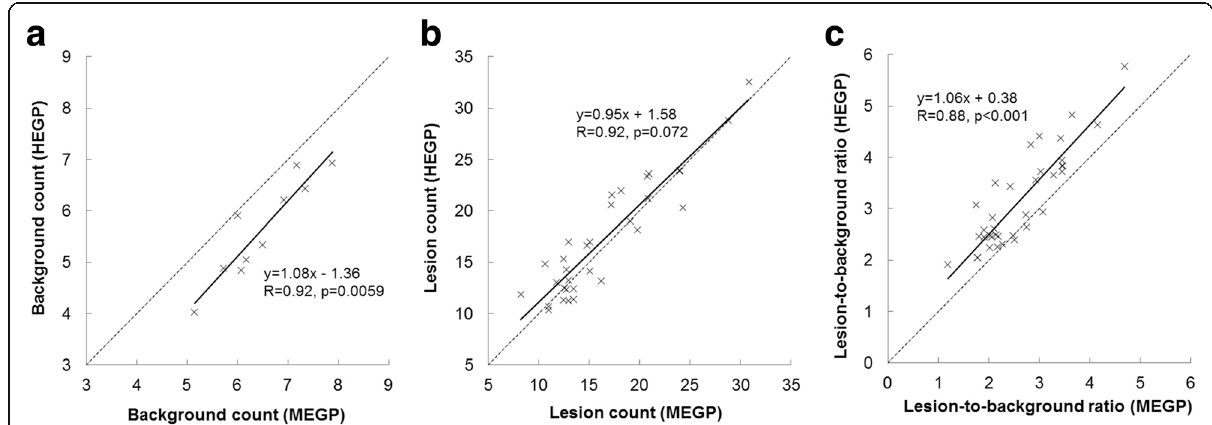
Fig. 5 a – c Comparison of background count (patient-based), lesion count and lesion-to-background ratio between the MEGP and HEGP collimators. MEGP medium-energy general purpose, HEGP high-energy general